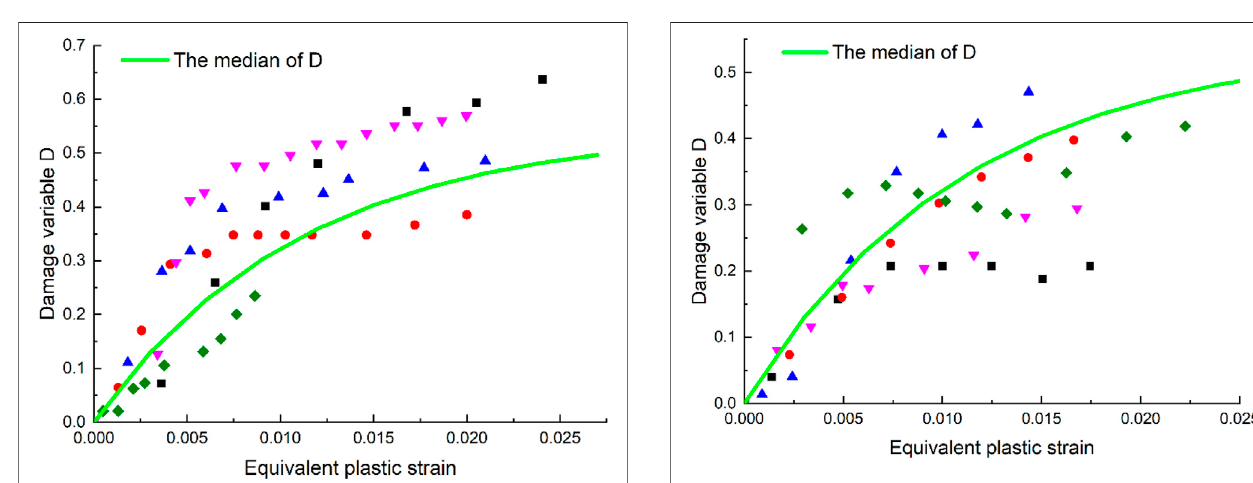
FIGURE9| Themediancurveregardingdamagevariablesofspecimens 1-5.